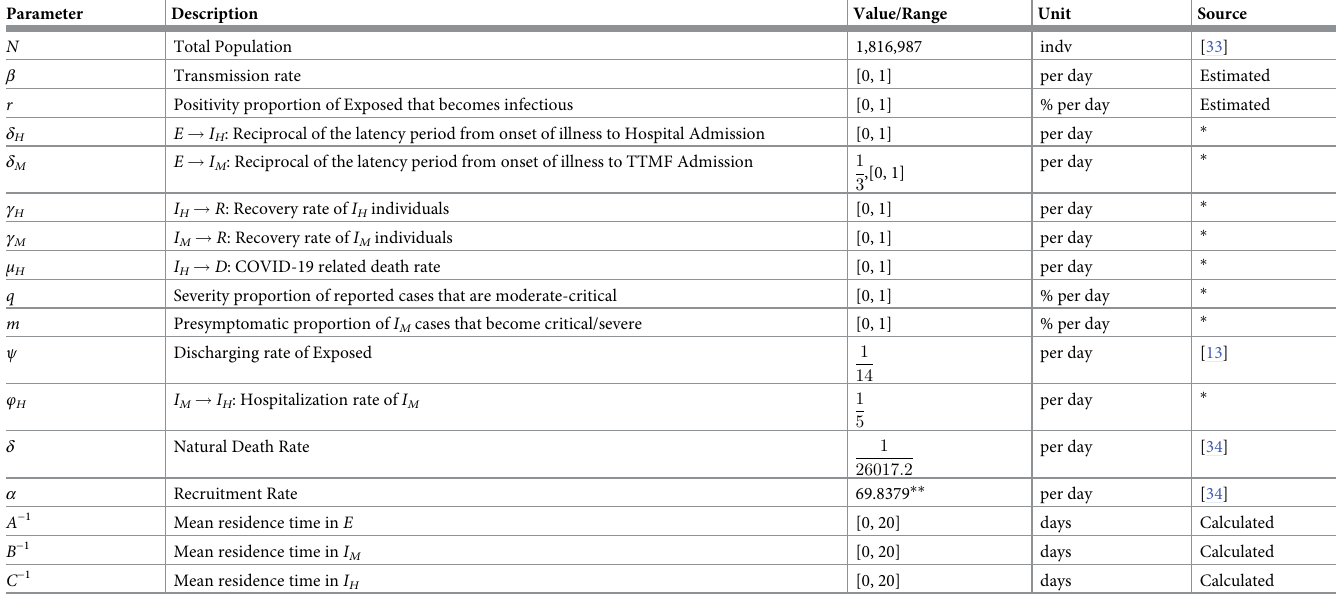
Table 2. Parameter description, values, and sources for Davao City,